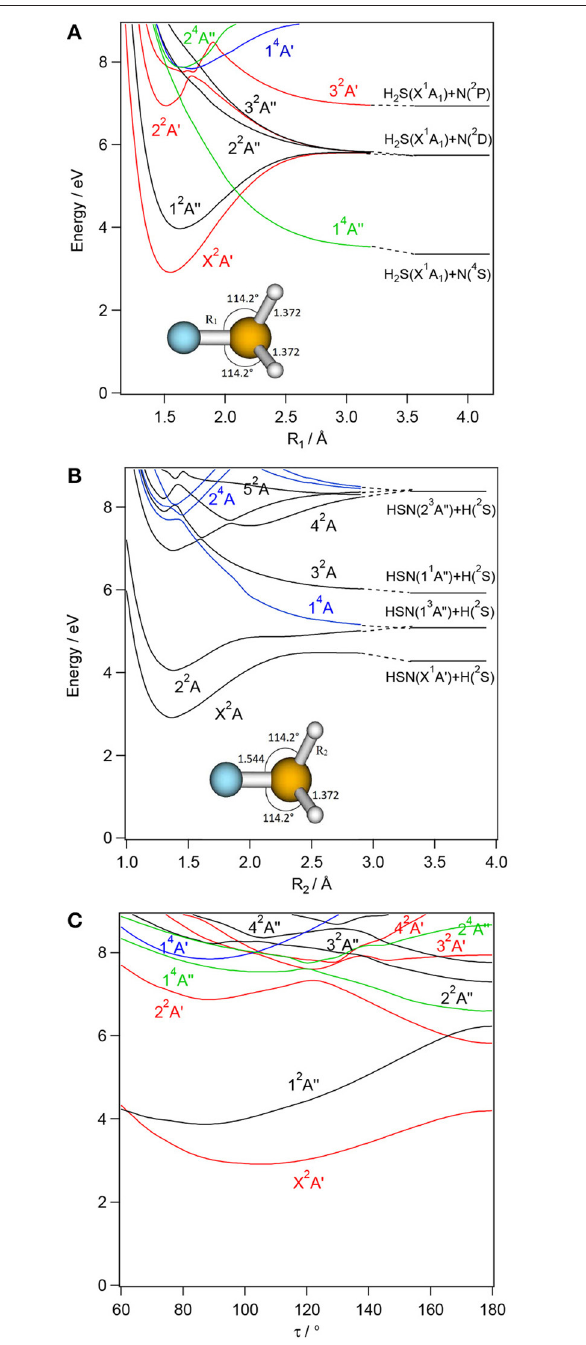
FIGURE 5 | CASSCF/MRCI/aug-cc-pV(5 + d)Z one-dimensional cuts of the 6D-PESs of the low lying electronic states of cis- HNSH along the SH (R 1 , A ), NS (R 2 , B ) and NH (R 3 , C ) stretching coordinates. The remaining internal coordinates are kept fixed at their values in the cis- HNSH(X 2 A ′′ ) state i.e., R 1 = 1.019 Å, R 2 = 1.617 Å; R 3 = 1.352 Å, θ 1 = 110.3 ◦ , θ 2 = 105.4 ◦ , and τ = 0 ◦ . The H + HNS/HSN, NH + SH asymptotes are located using the data in Supplementary Tables 8 , 9 and (Trabelsi et al., 2015) 1 . The reference energy is that of H 2 NS(X 2 B 1 ) at equilibrium.